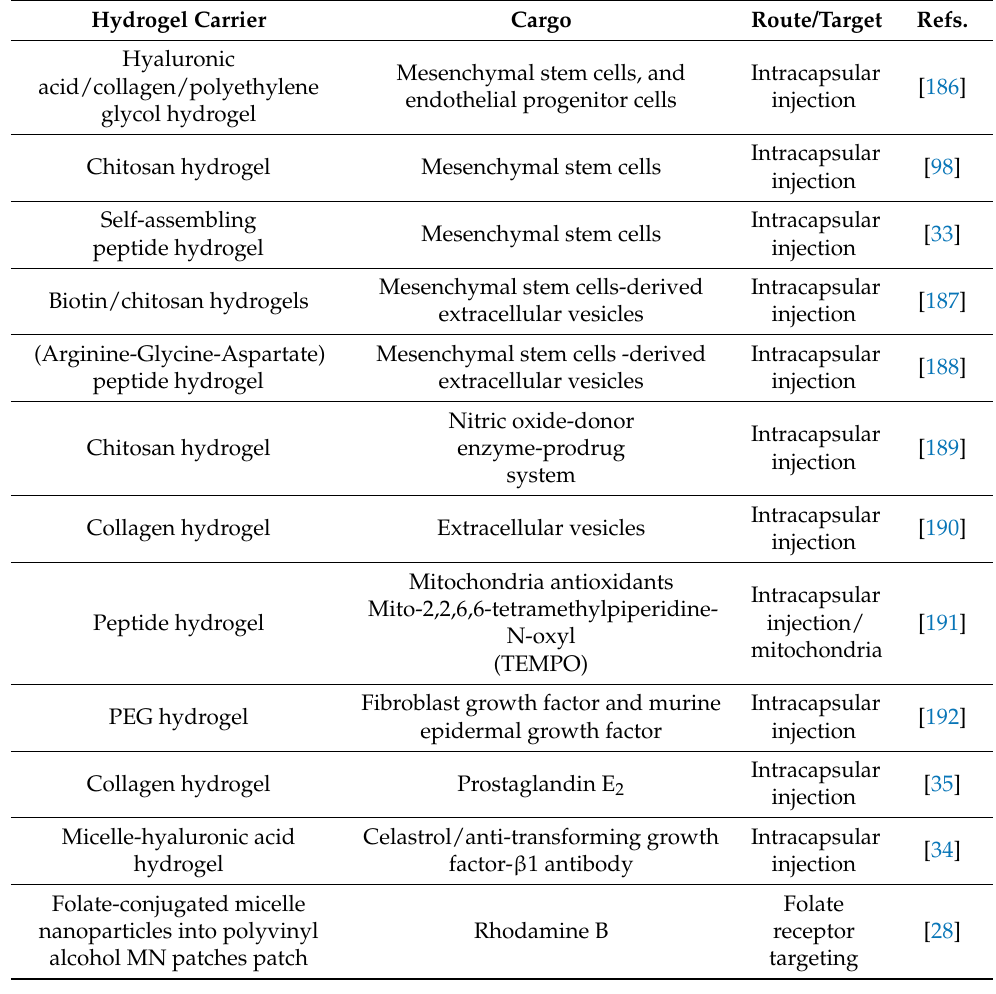
Table 5. Hydrogel-based therapies for kidney-targeted drug delivery systems. Hydrogel Carrier Cargo Route/Target